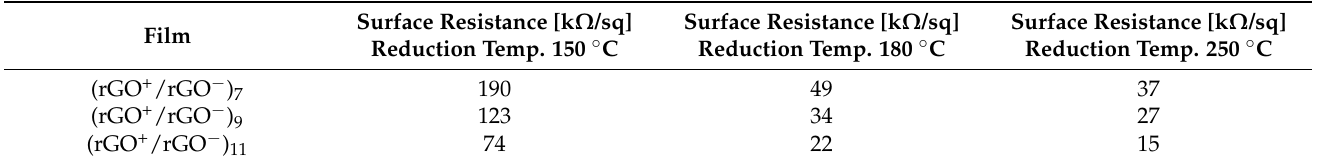
Table 2. Summary of the results of the surface resistance values for films (rGO + /rGO − ) n depending on the number of deposition cycles and the reduction temperature on polyimide plates.